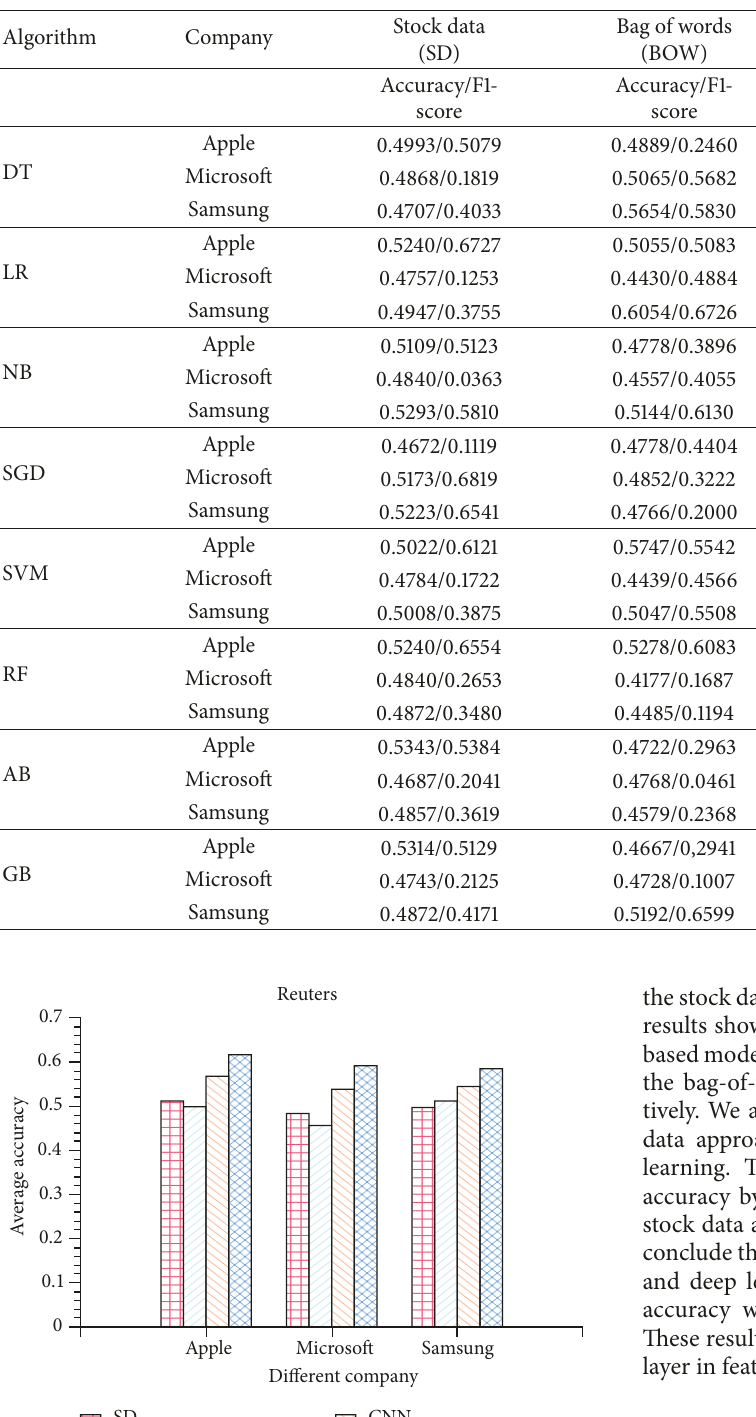
Table 9: Results for data extracted from Thomson Reuters.